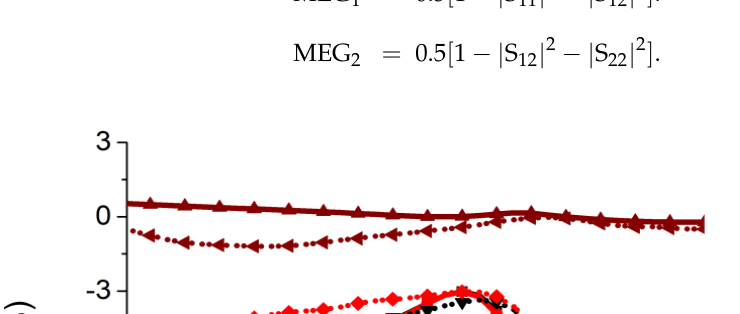
Figure 19. TARC of proposed two-port MIMO antenna.